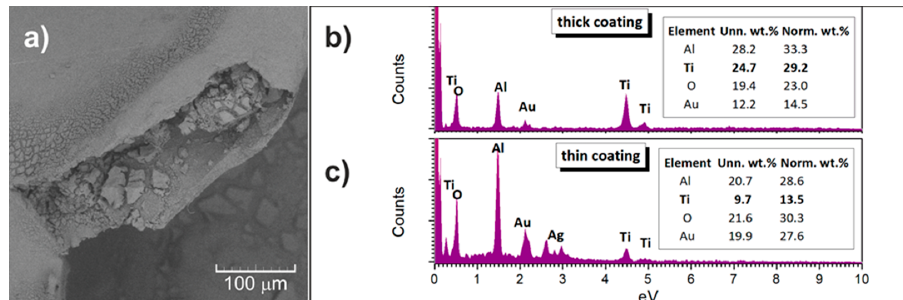
Figure 6. ( a ) SEM using back scatter (BS) electrons on TiO 2 -coated Al 2 O 3 foam, ( b ) EDS recorded from a wide area of the TiO 2 -coated Al 2 O 3 foam, ( c ) EDS recorded from a highly magnified area of the TiO 2 -coated Al 2 O 3 foam with a characteristic crack